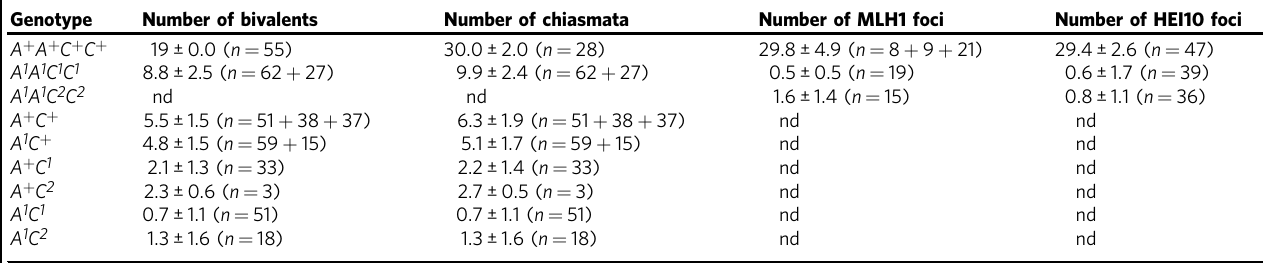
Table 1 Crossover reduction in euploid and allohaploid B. napus msh4 mutants Genotype Number of bivalents Number of chiasmata Number of MLH1